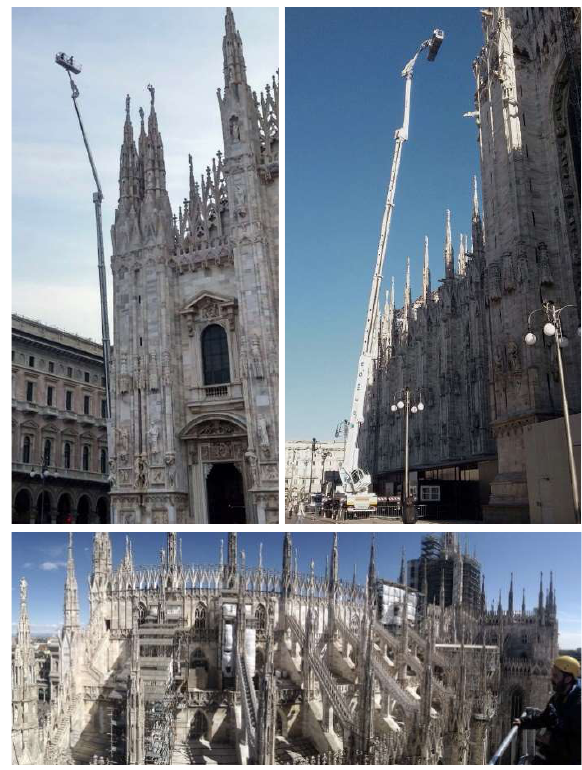
Figure 1. views of the cathedral’s exteriors: acquisitions from the platform for the South façade (top right) and for the North façade (top left). On the bottom a panoramic view of the South roofs from the platform. Notice the complexity of the decorative elements and the challenging illumination